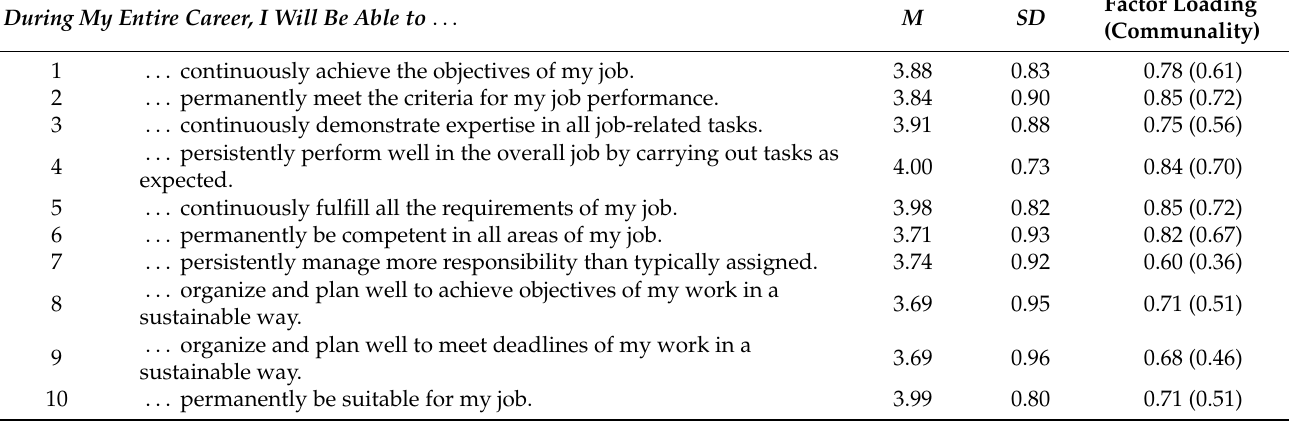
Table 1. Items, means, standard deviations and factor loadings of the E-SuPer instrument (Sample A, n = 153). During My Entire Career, I Will Be Able to . .